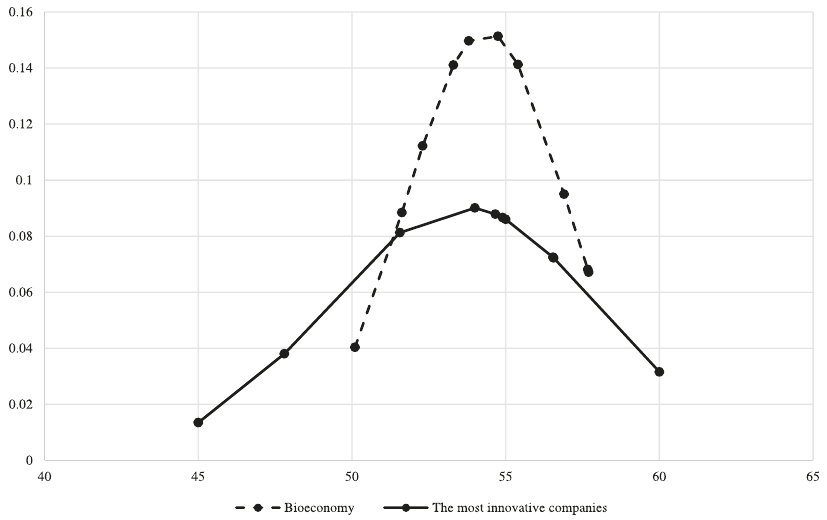
Fig. 3 Normal distribution of age in the bioeconomy and the most innovative companies. Age diversity in bioeconomy (dotted line) versus the most innovative companies (solid line). A narrower age spread is observed in the case of the bioeconomy